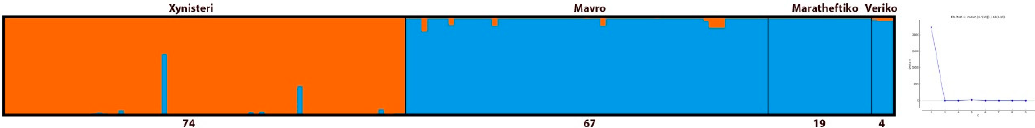
Figure 3. Structure analysis for Cypriot grapevine germplasm at K = 2 cluster and delta K probability for Cypriot genotypes. Numbers correspond to the analyzed samples.